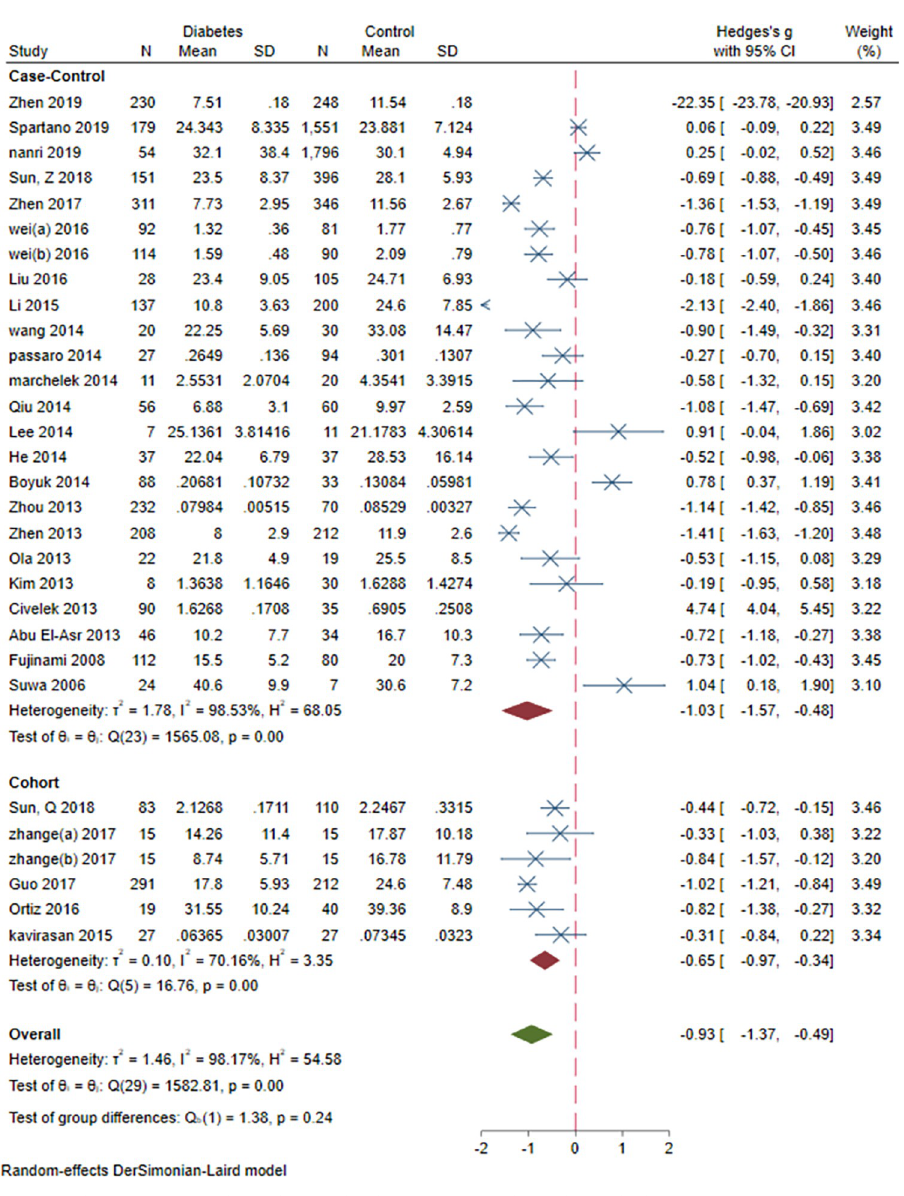
Fig 12. Subgroup meta-analysis of BDNF levels in patients with DM by study